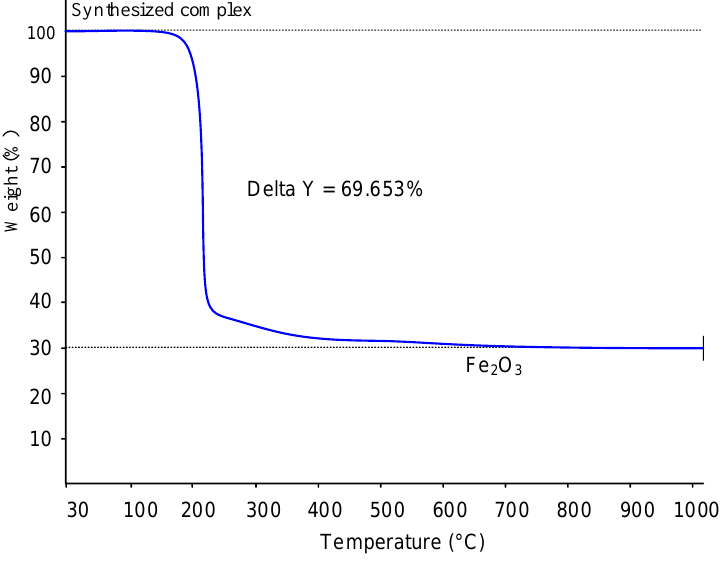
Figure 1. TGA analysis of iron citrate powder. The temperature increased from 30 °C to 900 °C at 200 °C min −1 .